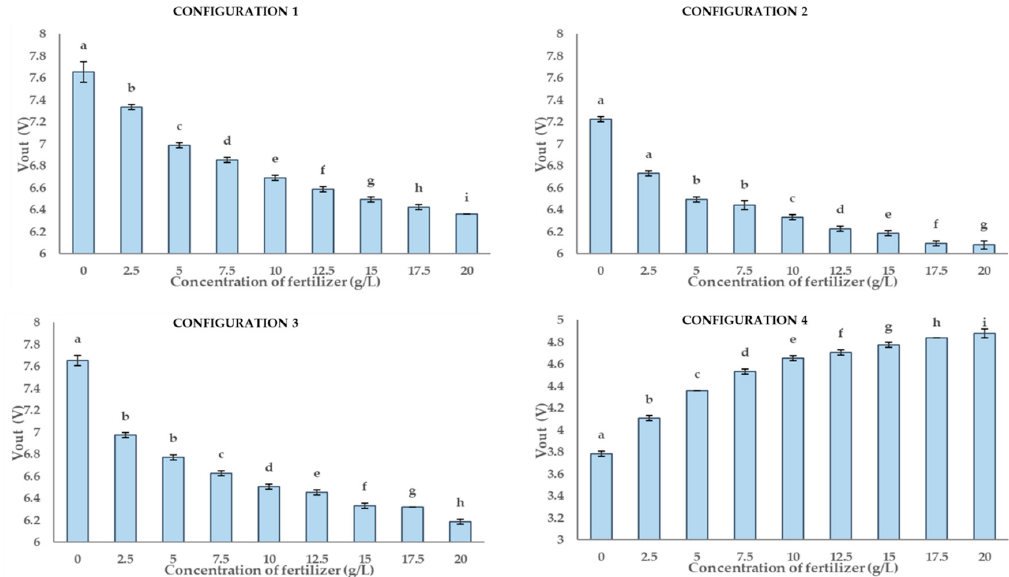
Figure 15. The graph presents a multi-range analysis for the four configurations where they are drawn by columns. Each column contains non-significant values between them. The di ff erent letters show that the values are statistically significant. In each column the vertical bar on it represents the